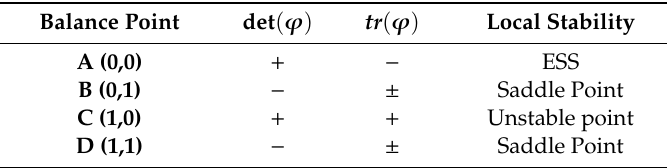
Table 3. Stability analysis of Case 1.